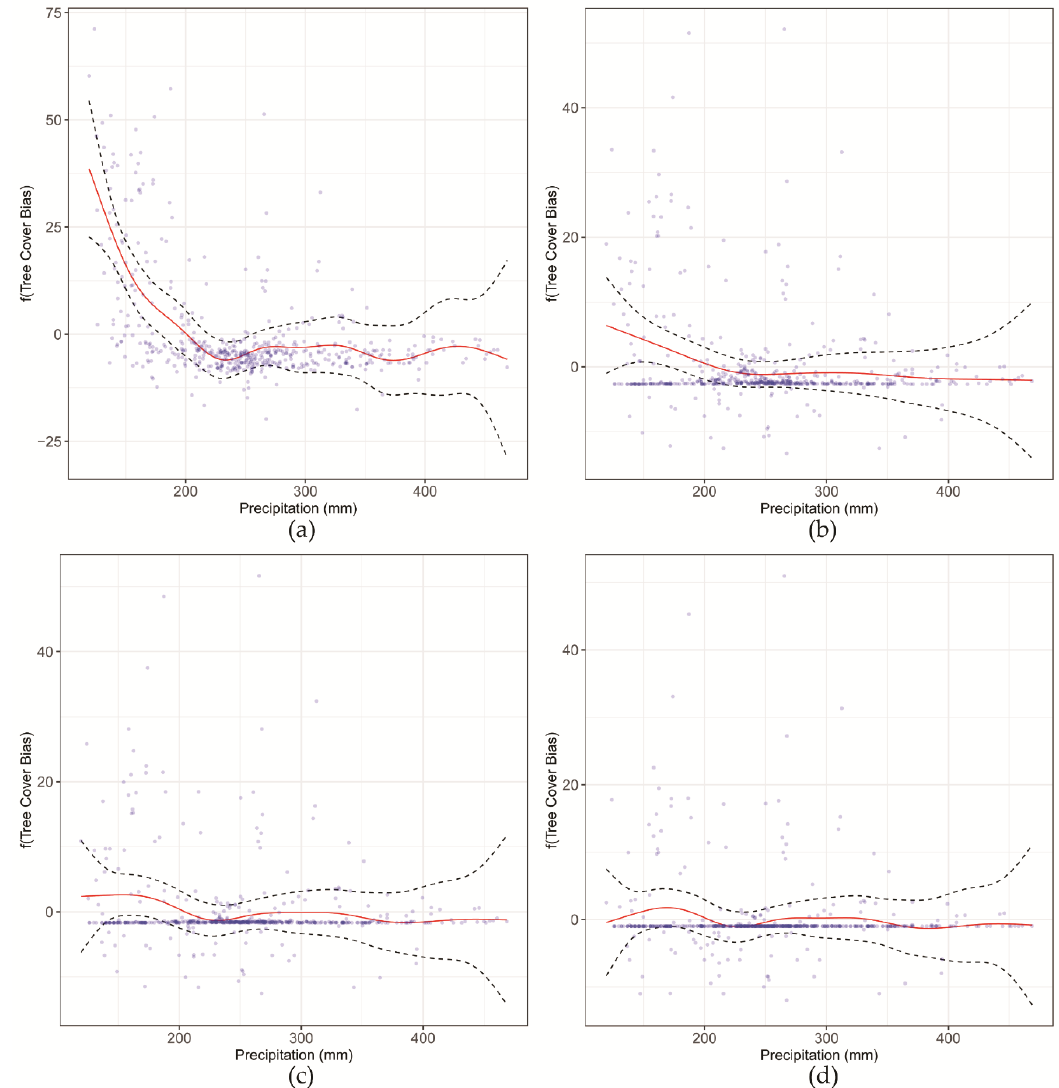
Figure A5. The fit of the three iterations of GAM models to the calculated bias in tree cover estimates is shown, with the partial term for precipitation displayed. Panel ( a ) shows the fit from the first iteration, panel ( b ) shows the fit from the second iteration, and panel ( c ) shows the fit from the third iteration (Figure 1). Panel ( d ) shows a fourth iteration of precipitation against the bias remaining in the final revised GFC tree cover data; this fourth GAM is nonsignificant ( p = 0.48).